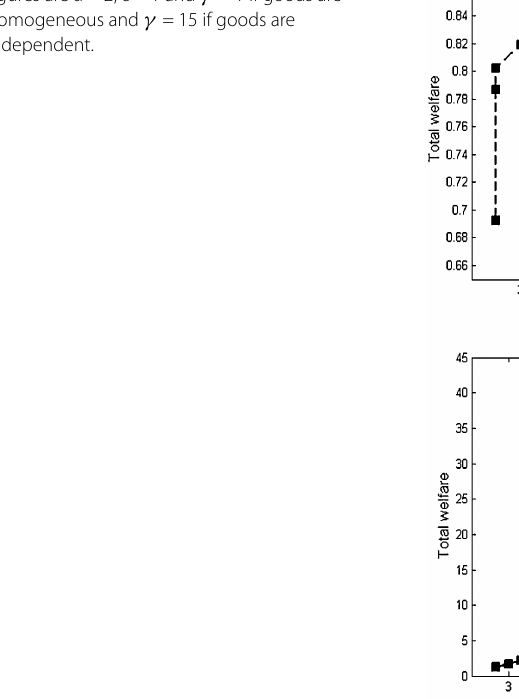
Figure 8 The welfare of the efficient networks. For 3 ≤ n ≤ 30, the parameters used to plot the figures are a = 2, c = 1 and γ = 1 if goods are homogeneous and γ = 15 if goods are